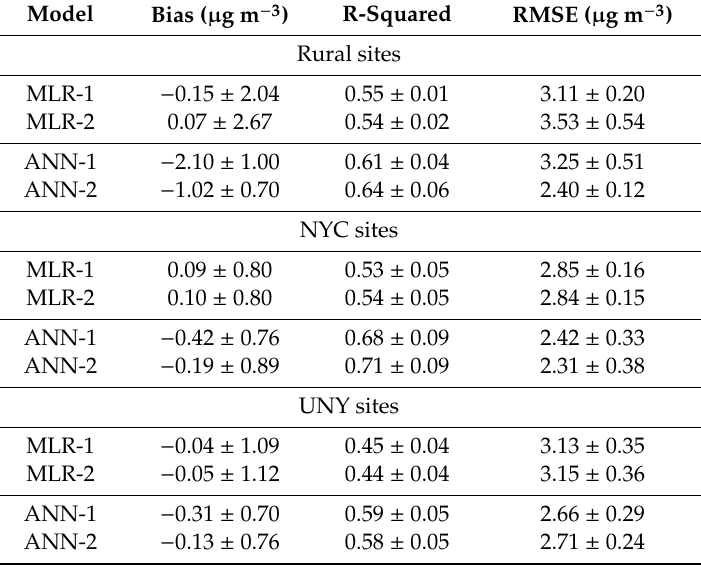
Figure 3. Di ff erences of bias (1), R-squared (2) and RMSE (3) values at selected sites between the ( a-1 , a-2 , a-3 ) MLR-1 and MLR-2 models, and the ( b-1 , b-2 , b-3 ) ANN-1 and ANN-2 models. Di ff erences were defined as the statistical scores of set 2 model minus those of set 1 model. Table 4. Averaged statistical scores of four models at rural, NYC and UNY sites.